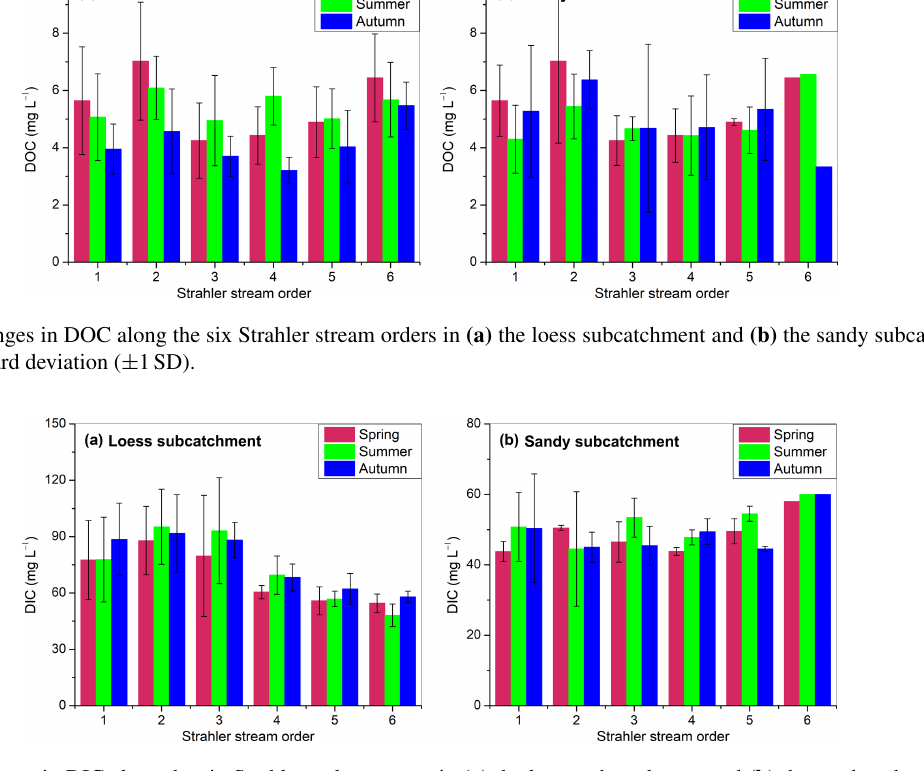
Figure 3. Spatial changes in DIC along the six Strahler order streams in (a) the loess subcatchment and (b) the sandy subcatchment. Error bars denote the standard deviation ( ±